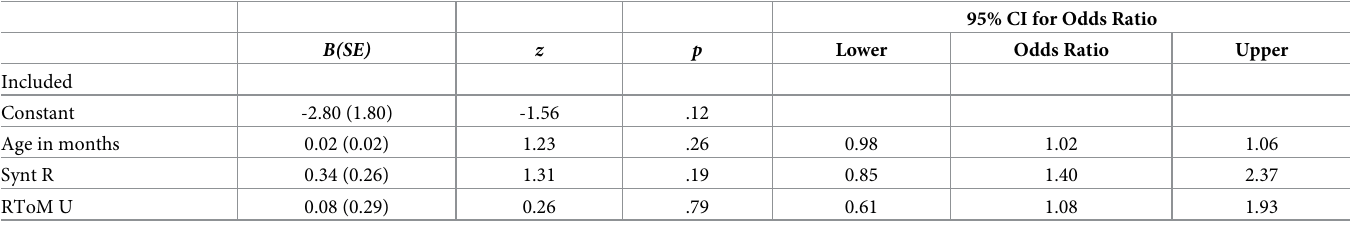
Table 8. Results of the logistic regression model predicting children’s TB performance with their age in months and their performance in tasks of syntactic recur- sion (Synt. Recurs.) and Recursive ToM understanding (RToM